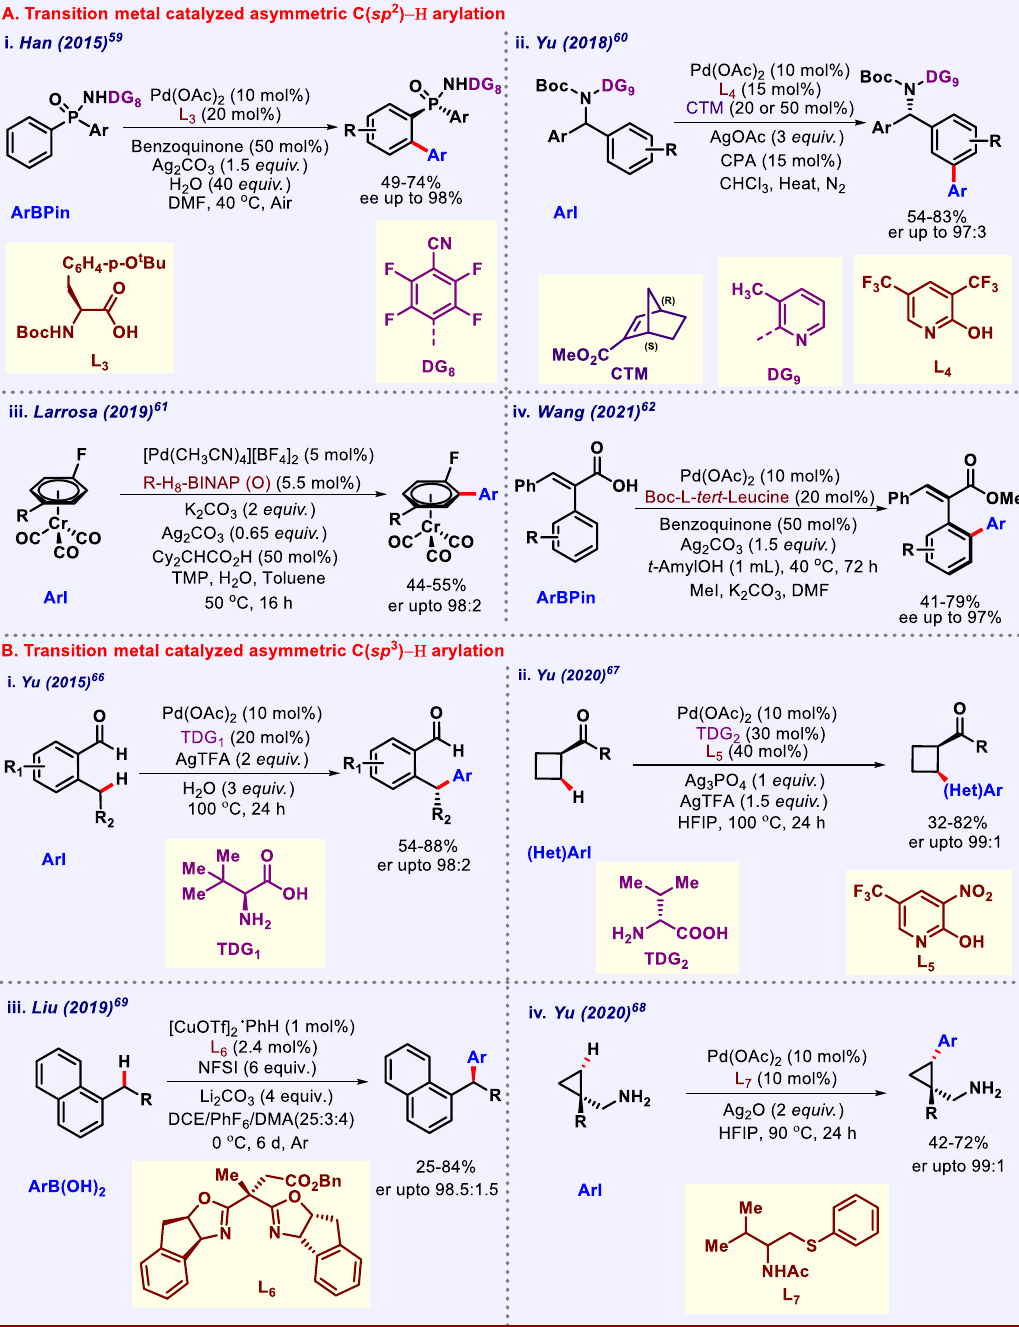
Fig. 4 Transition-metal-catalyzed asymmetric C – H arylation. A Asymmetric C( sp 2 ) – H arylation. B Asymmetric C( sp 3 ) – H